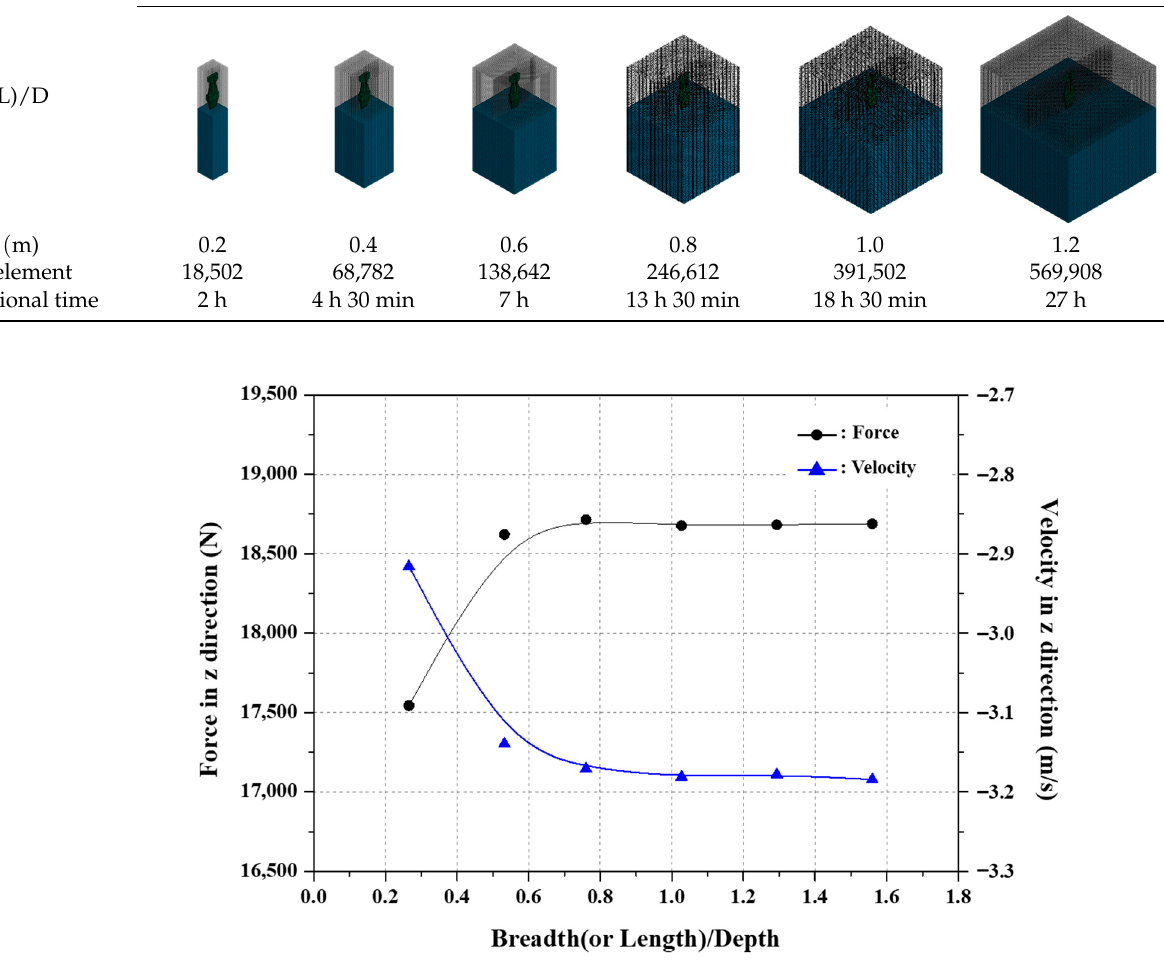
Figure 12. The effect of fluid domain Figure 12. The effect of fluid domain size. Figure 12. The effect of fluid domain size. Figure 12. The effect of fluid domain size. Figure 12. The effect of fluid domain size. Figure 12. The effect of fluid domain size. Figure 12. The effect of fluid domain size.